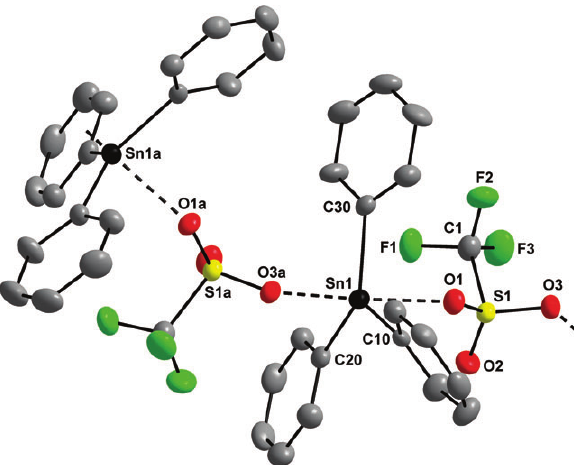
Figure 1 Crystal structure of Ph ellipsoids and the crystallographic numbering scheme